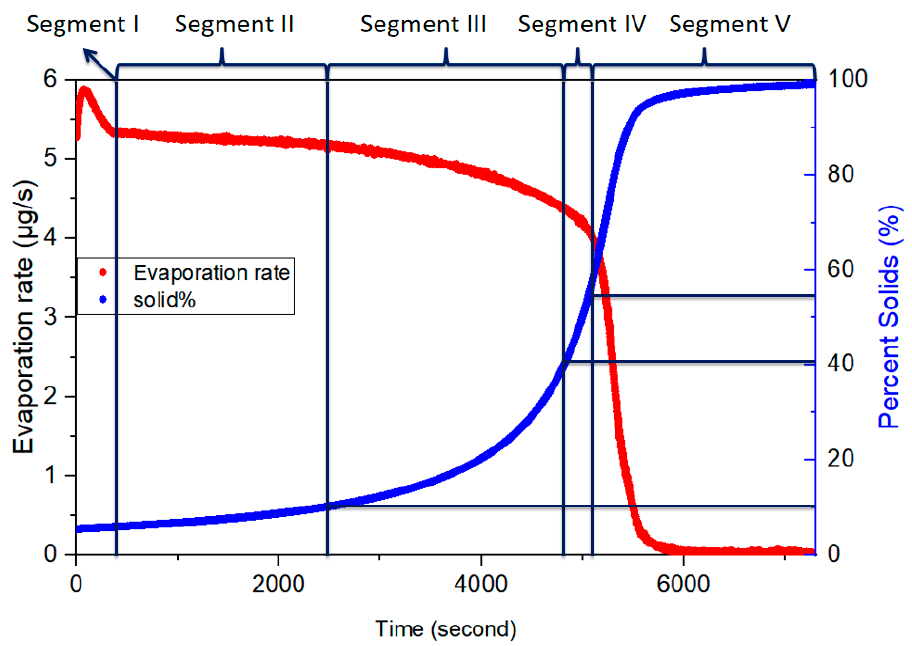
Figure 5. Segments I, II, III, IV and V during the isothermal process.